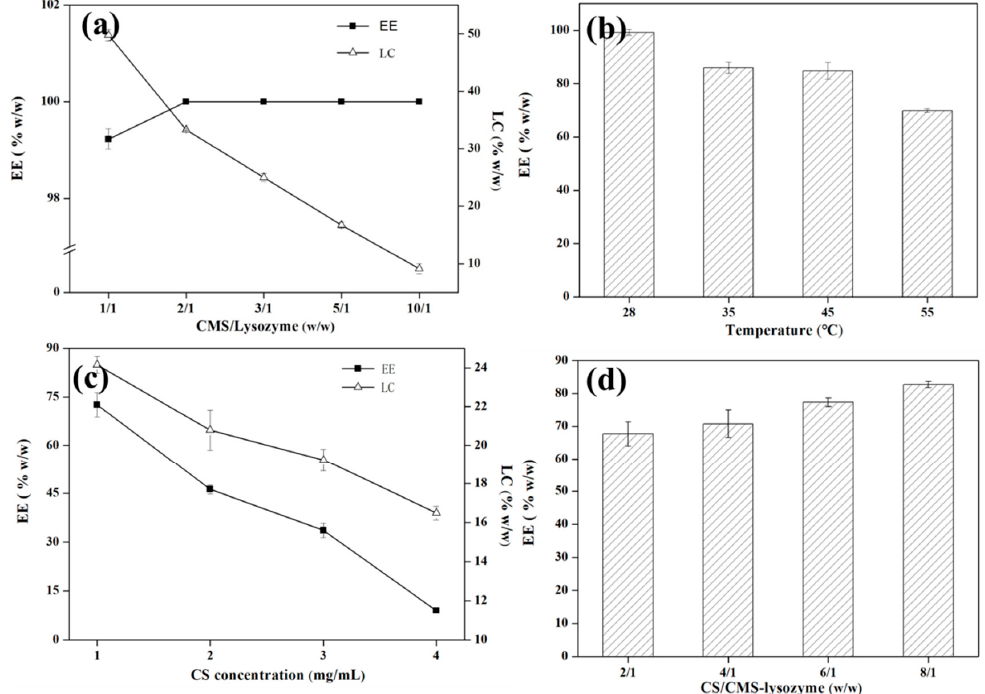
Figure 2. Optimization of encapsulation efficiency (EE) and loading capability (LC). EE and LC as a function of CMS-to-lysozyme mass ratio ( a ) and CS concentration ( c ). EE as a function of temperature ( b ) and ( d ) mass ratio of CS and CMS-lysozyme. Bars represent the corresponding standard deviations ( n = 3).